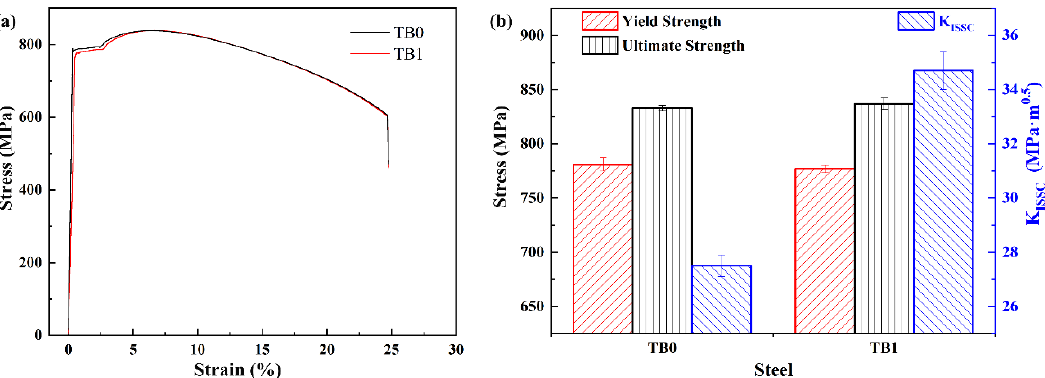
Figure 5. ( a ) Tensile stress-strain curves of TB0 and TB1 steels showing the similar mechanical properties, and ( b ) the values of yield and ultimate strengths and K ISSC of TB0 and TB1 steels.